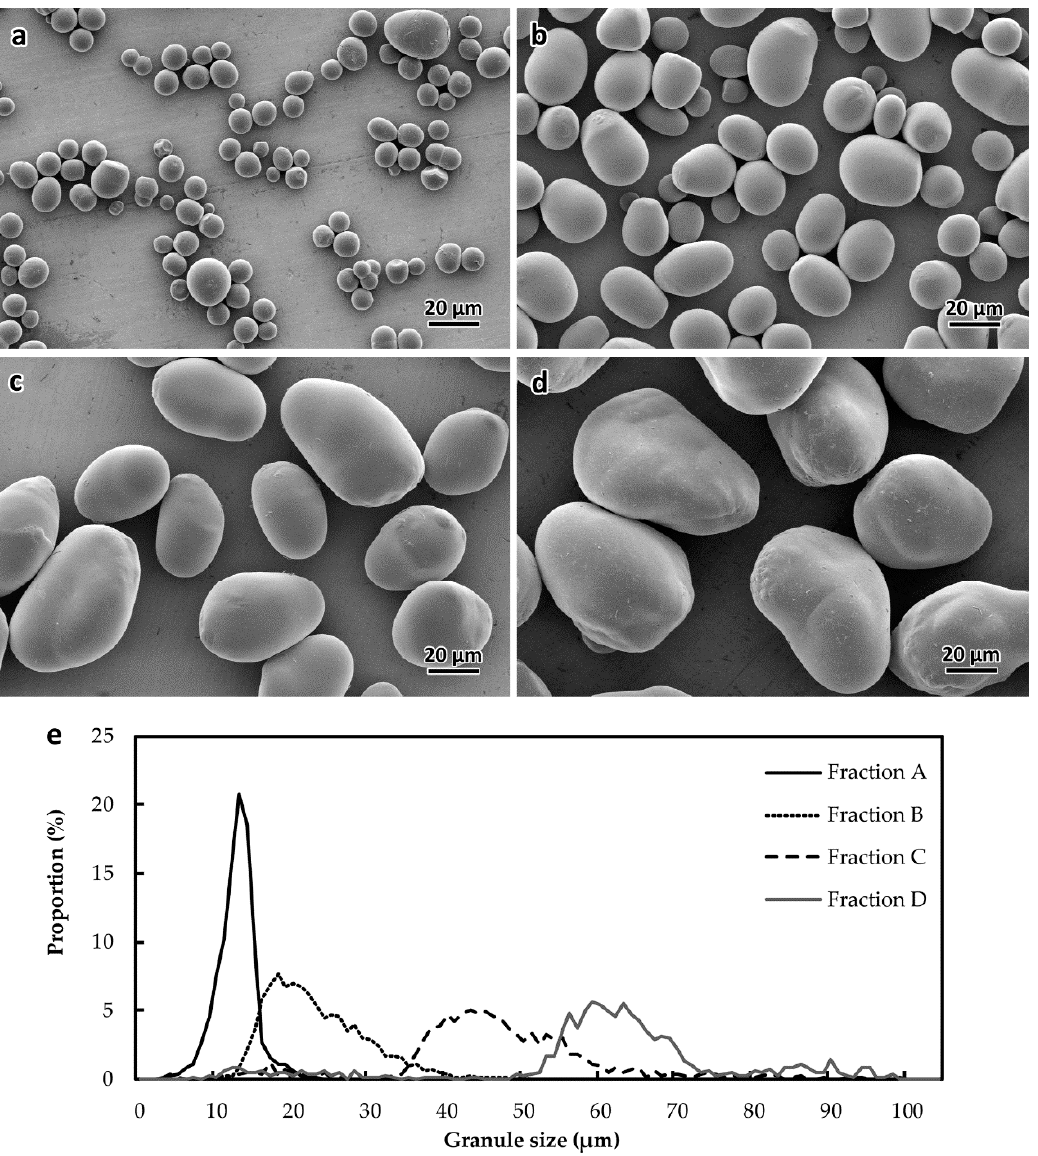
Figure 2. Morphology of size-fractionated starch granules. Scanning electron microscopy images of fractions A ( a ), B ( b ), C ( c ), and D ( d ). ( e ) Size distribution of each fraction. 3035 granules from fraction A, 3436 granules from fraction B, 1198 granules from fraction C, and 784 granules from fraction D were used for